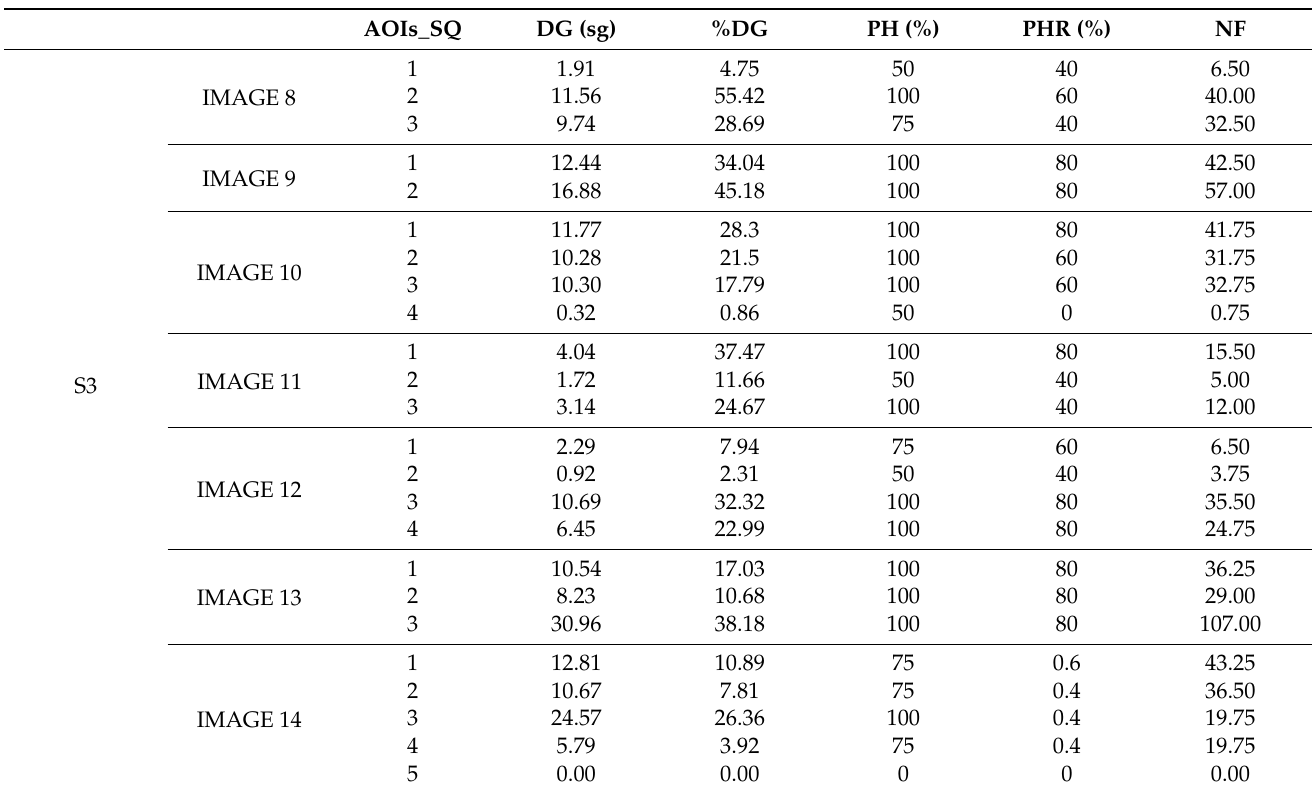
Table 3. Fixations and gaze by AOI for S3.